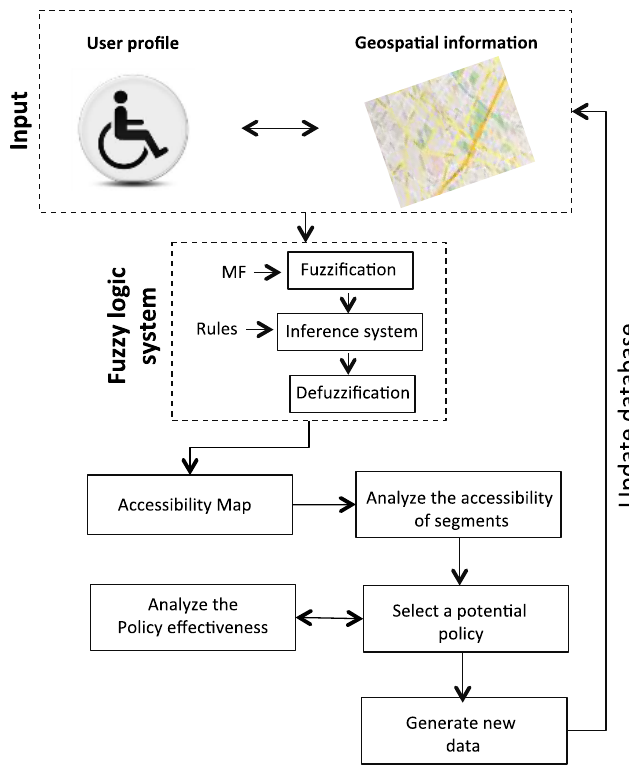
Figure 1. An overview of the proposed methodology.